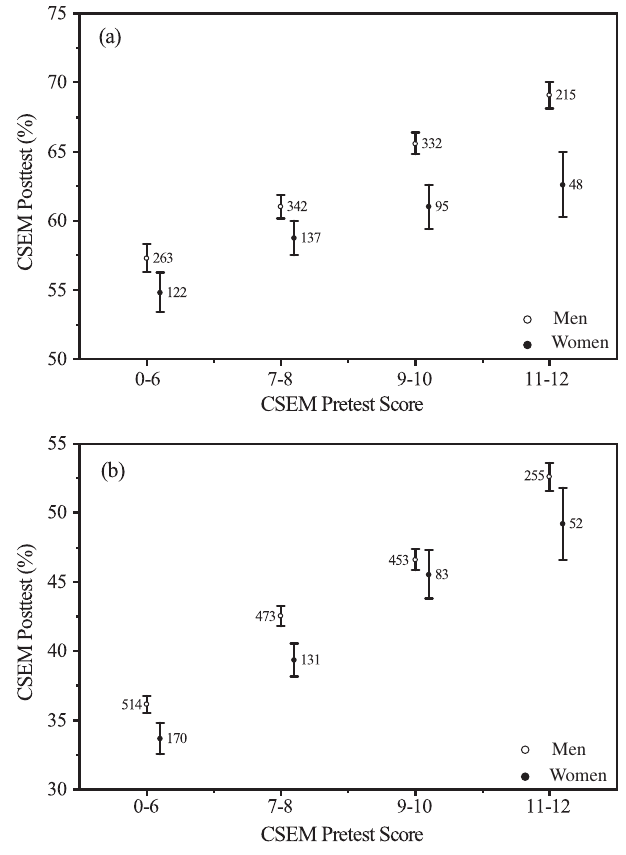
FIG. 4. CSEM post-test percentage vs CSEM pretest: (a) Sam- ple 2 and (b) sample 3B. The number next to the data point is the number of students within each pretest